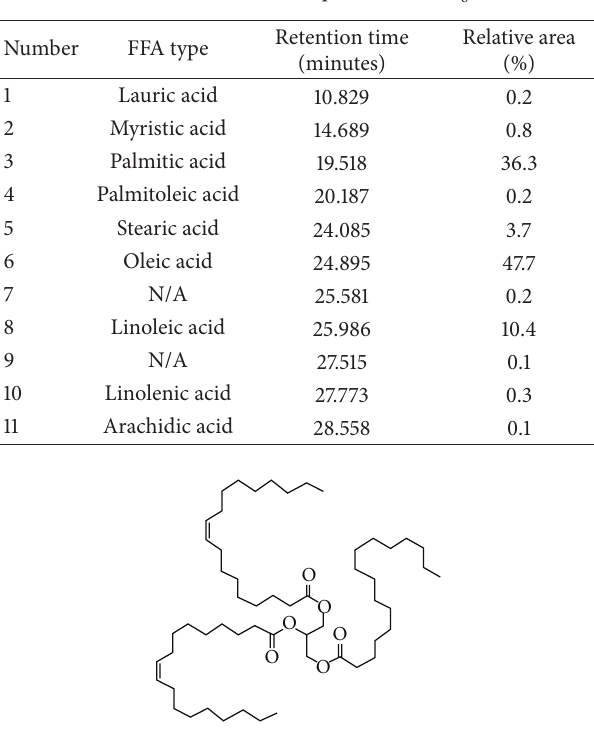
Figure 3: Major structure of TAG PO